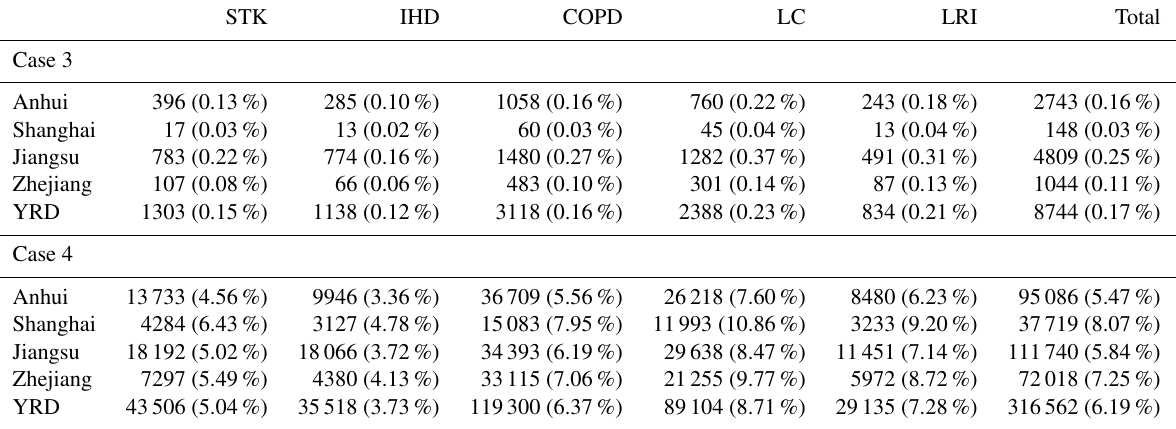
Table 6. The reduced cases and rates (in parentheses) of YLL resulting from implementation of the ultra-low emission policy in the YRD